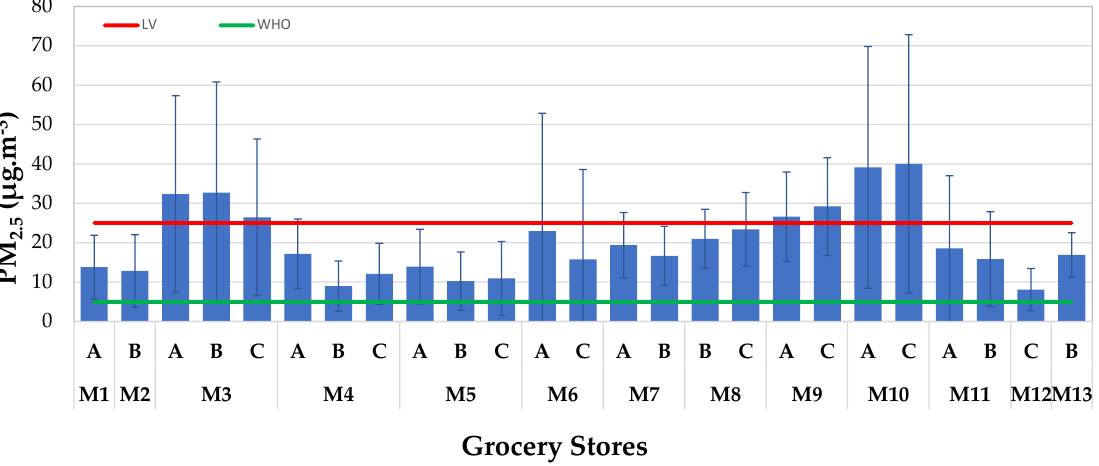
Figure 6. PM 2.5 levels assessed in all locations of the studied GSs. The red line represents the limit value (LV) of 25 µg.m −3 established by Portuguese legislation [34] and the green line represents the air quality guideline of 5 µg.m −3 established by the WHO [39].